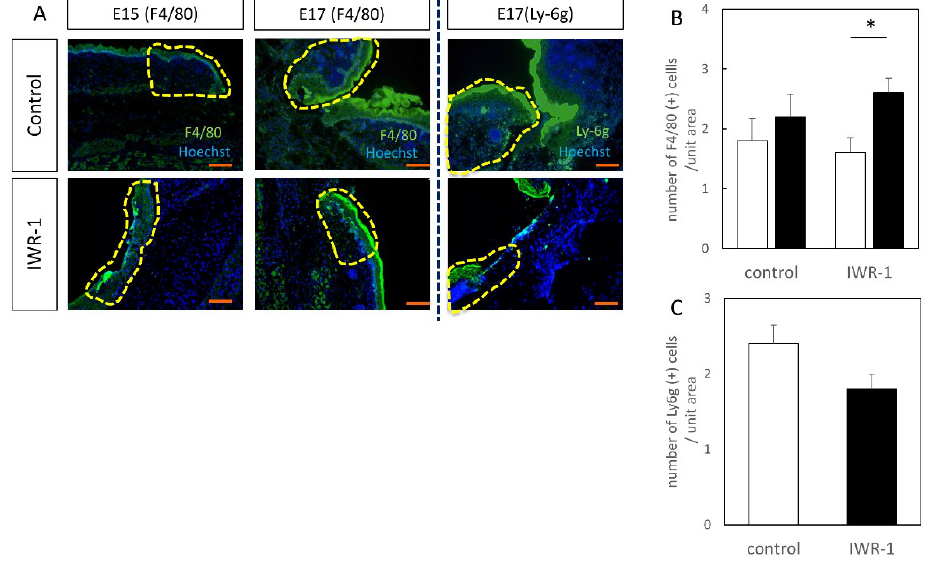
Figure 8. Localization of inflammatory cells in wound. ( A ) Immunofluorescence staining, scale bar = 100 µ m. ( B ) F4/80-positive cell counting. F4/80-positive cells were significantly increased in the E17-48H IWR-1 treatment group. ( C ) Ly-6g-positive cell counting. * p < 0.05.